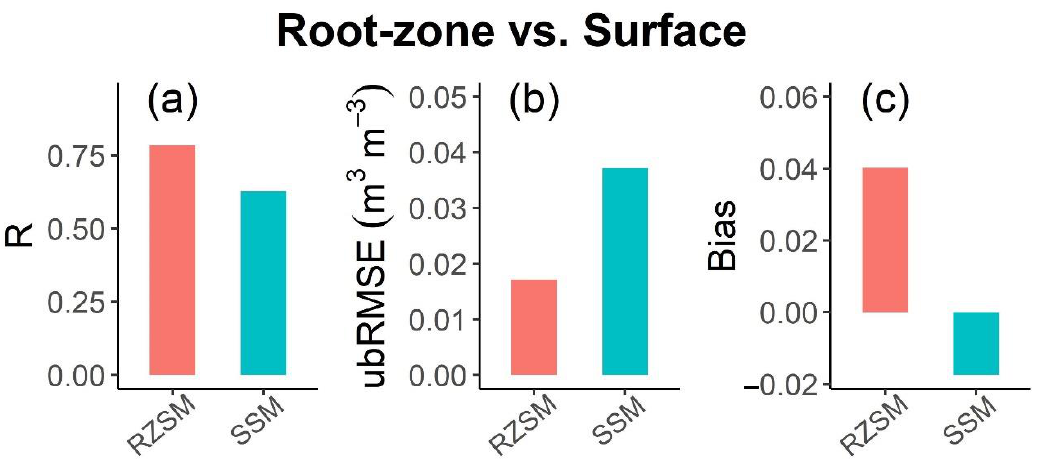
Figure 5. The averaged performance metrics (R ( a ), ubRMSE ( b ), and bias ( c )) for the SPL4SMGP SSM and RZSM estimations against the sparse network sites (across 34 validation sites).